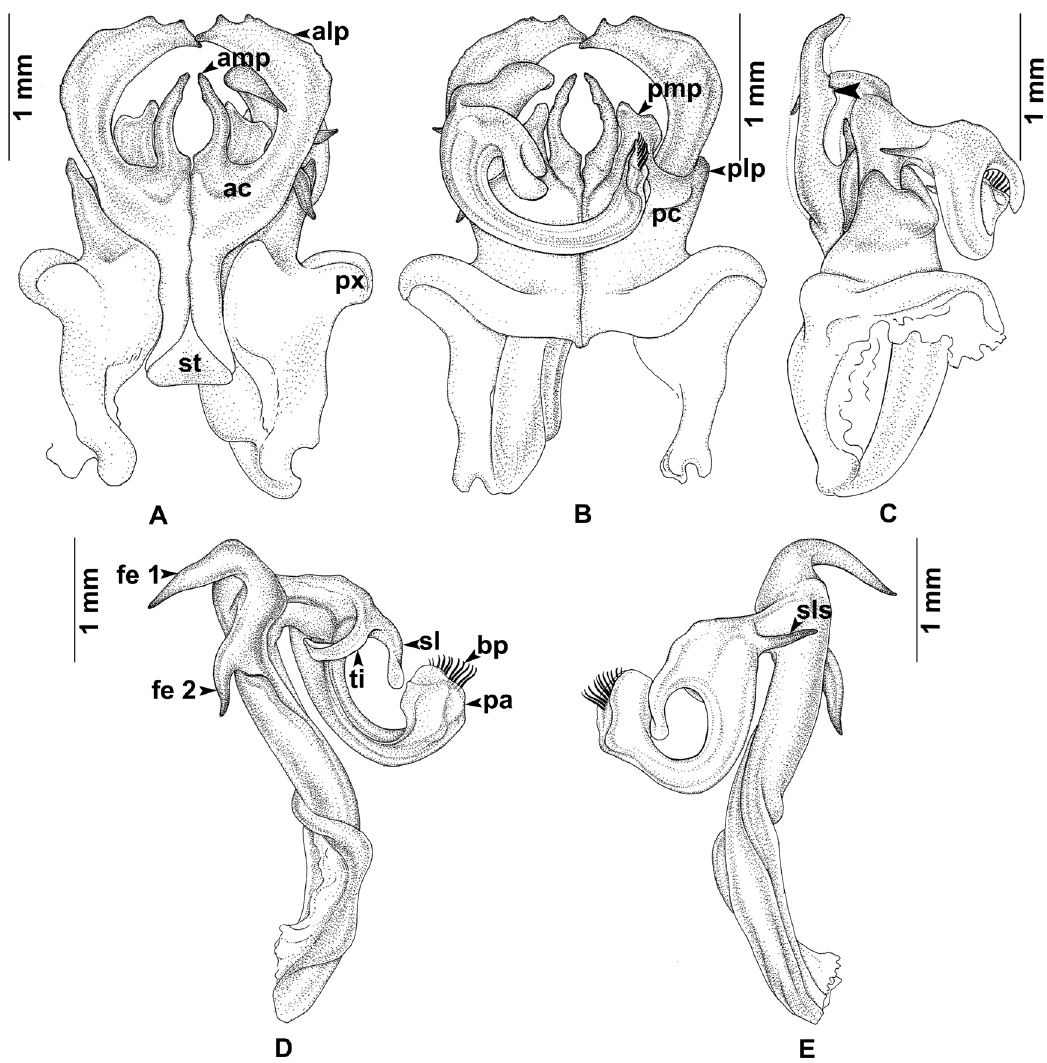
Fig. 9. Thyropygus undulatus sp. nov., from Khao Phanom Bencha, holotype (CUMZ-D00087), ♂, gonopods. A . Anterior view, left telopodite removed. B . Posterior view, left telopodite removed. C . Lateral view. D . Left telopodite, posterior-mesal view. E . Left telopodite, anterior-lateral